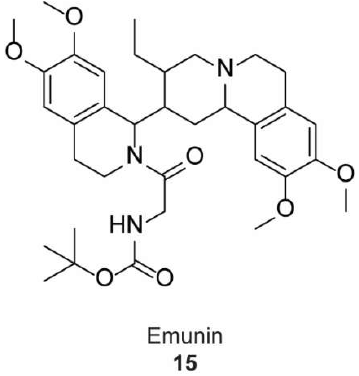
Figure 5. Chemical structure of emunin.